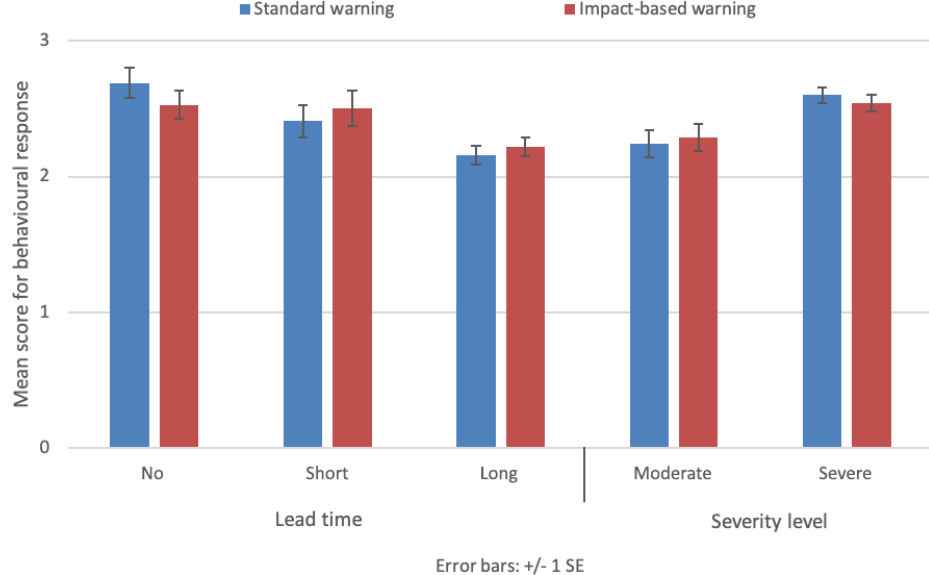
Figure 2. Mean self-reported behavior in response to two warning types (standard and impact-based) and the three lead times (no, short and long) to the two severity levels (moderate and severe). Behavioral response was measured on a five-point scale from no response to strongest risk-minimizing behavior. For lead times, “no” indicates that respondents considered the warning during the event, “short” refers to 0–6h prior to the event, and “long” refers to more than 6h. Error bars indicate + / − 1 the standard error ( N =